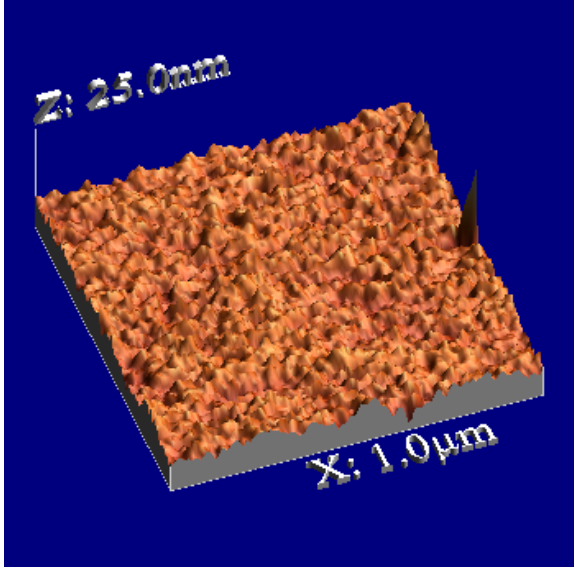
Fig. 6 AFM images of silica (TMOS) hybrids containing 5 mol % calcium